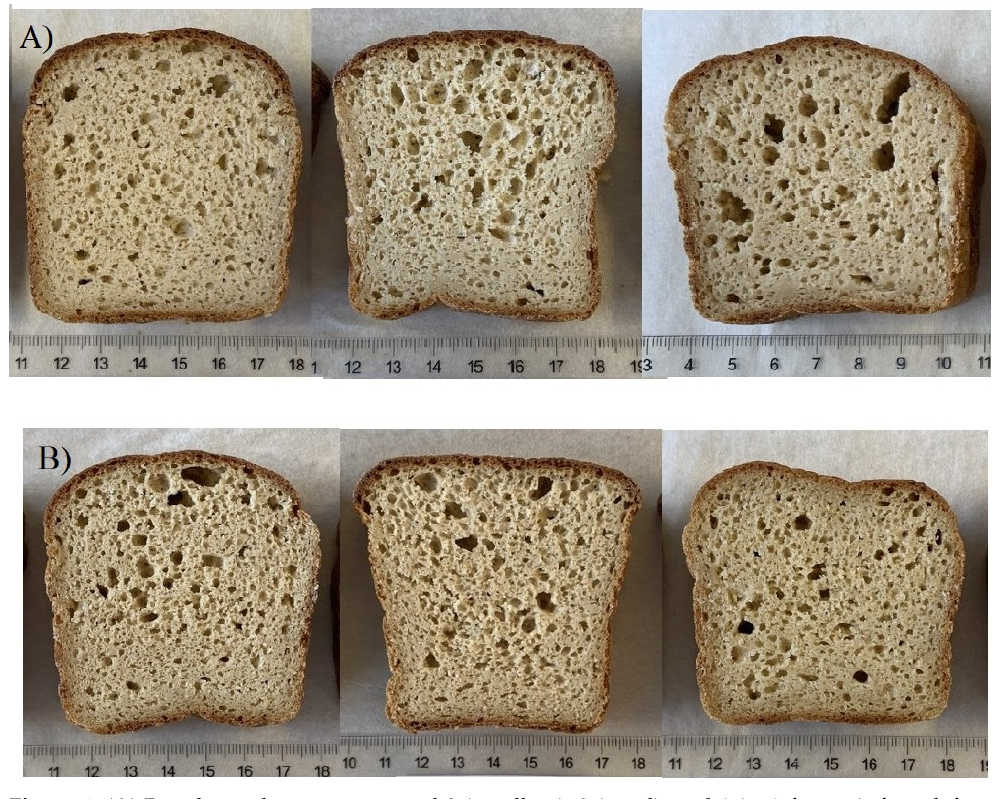
Figure 1. ( A ) Bread crumb structures rated 3 (excellent), 2 (good), and 1 (satisfactory), from left to right. ( B ) Bread shapes rated 3 (excellent), 2 (good), and 1 (satisfactory), from left to